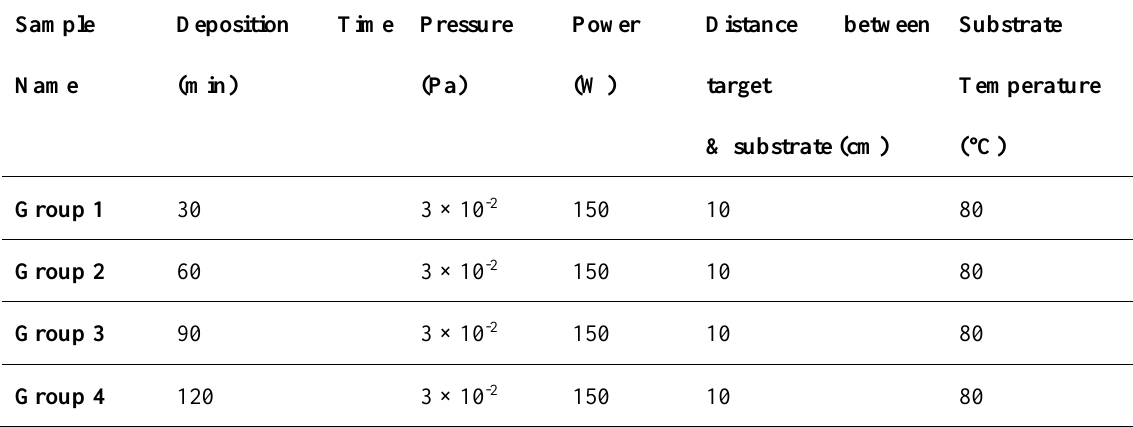
Table 1: The working conditions of deposition Sr-HA on the PEKK